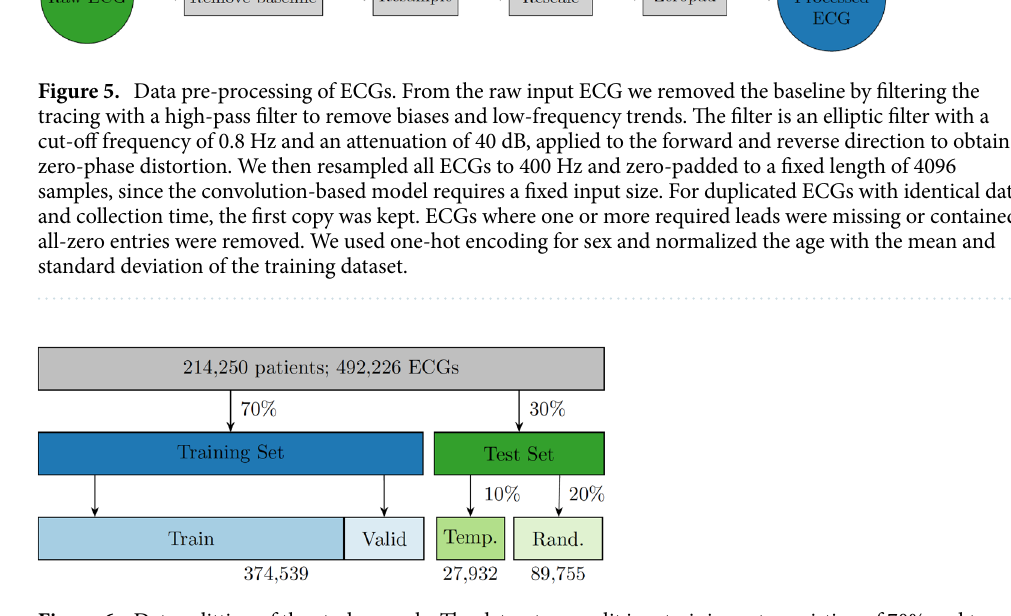
ferent scenarios. The 10% split contains patients with a first recorded admission date after 2016-01-01 or later, hence temporally separated from the training data set which included patients with a first recorded admission